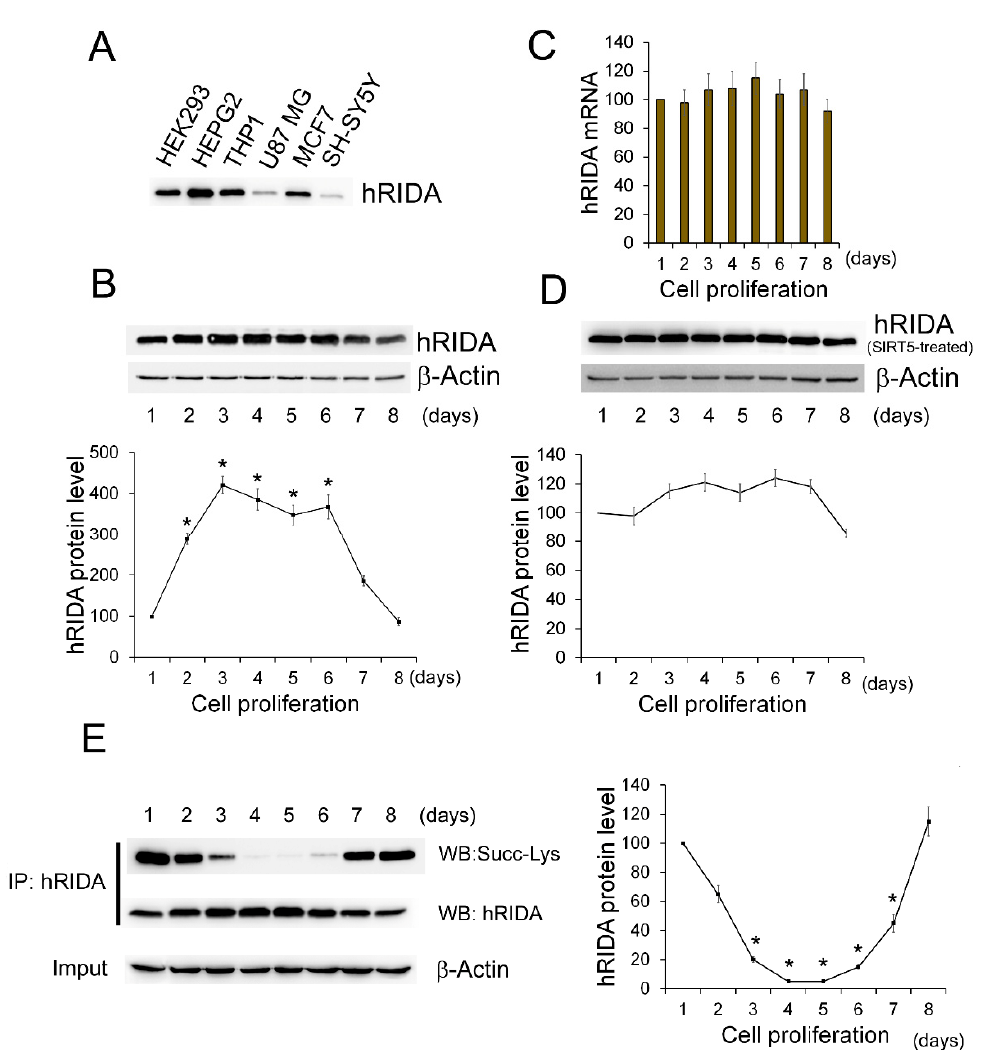
Figure 1. Expression of hRIDA in cultured cell lines: evidence for hRIDA K-succinylation. ( A ) The expression of hRIDA was analyzed in HEK293, HepG2, THP1, U87MG, MCF7 and SH-SY5Y cells by Western blotting. 20 µ g of protein extract from each cell line was fractionated on 15% SDS-PAGE, transferred onto nitrocellulose membrane and immunodecorated with the hRIDA polyclonal antibody. The equivalent amount of protein extract from the analyzed cell lines was checked by Ponceau S staining of membrane (data not shown). ( B ) The expression of hRIDA was monitored during HEK293 cell growth, by harvesting cells at several days (1–8 days) following seeding. hRIDA level was determined as described in ( A ) and quantified by densitometry. The content of hRIDA was normalized with β -actin and expressed as percentage with respect to hRIDA content in cells at day 1. ( C ) Cells were harvested at different days of cell growth and total RNA was extracted. hRIDA mRNA abundance was determined by RT-qPCR and normalized with 18S rRNA. Values are reported in histograms as percentage relative to the cells at day 1. ( D ) The content of hRIDA was analyzed in cells harvested at different days (1–8) and protein extracts were subjected to in vitro desuccinylation with SIRT5. The content of hRIDA was determined as described in ( B ). ( E ) hRIDA was immunoprecipitated with polyclonal antibody, fractionated on 15% SDS-PAGE, and transferred onto nitrocellulose membrane. The membrane was immunodecorated using the pan-succinyl-lysine (upper panel) and hRIDA polyclonal (middle panel) antibodies. The content of K-succinylated hRIDA was normalized with respect to β -actin in the input protein extracts (lower panel) and reported in the graph as percentage with respect to the cells at day 1. Values are means ± S.D. of three independent experiments. *, value significantly different from the control, p <